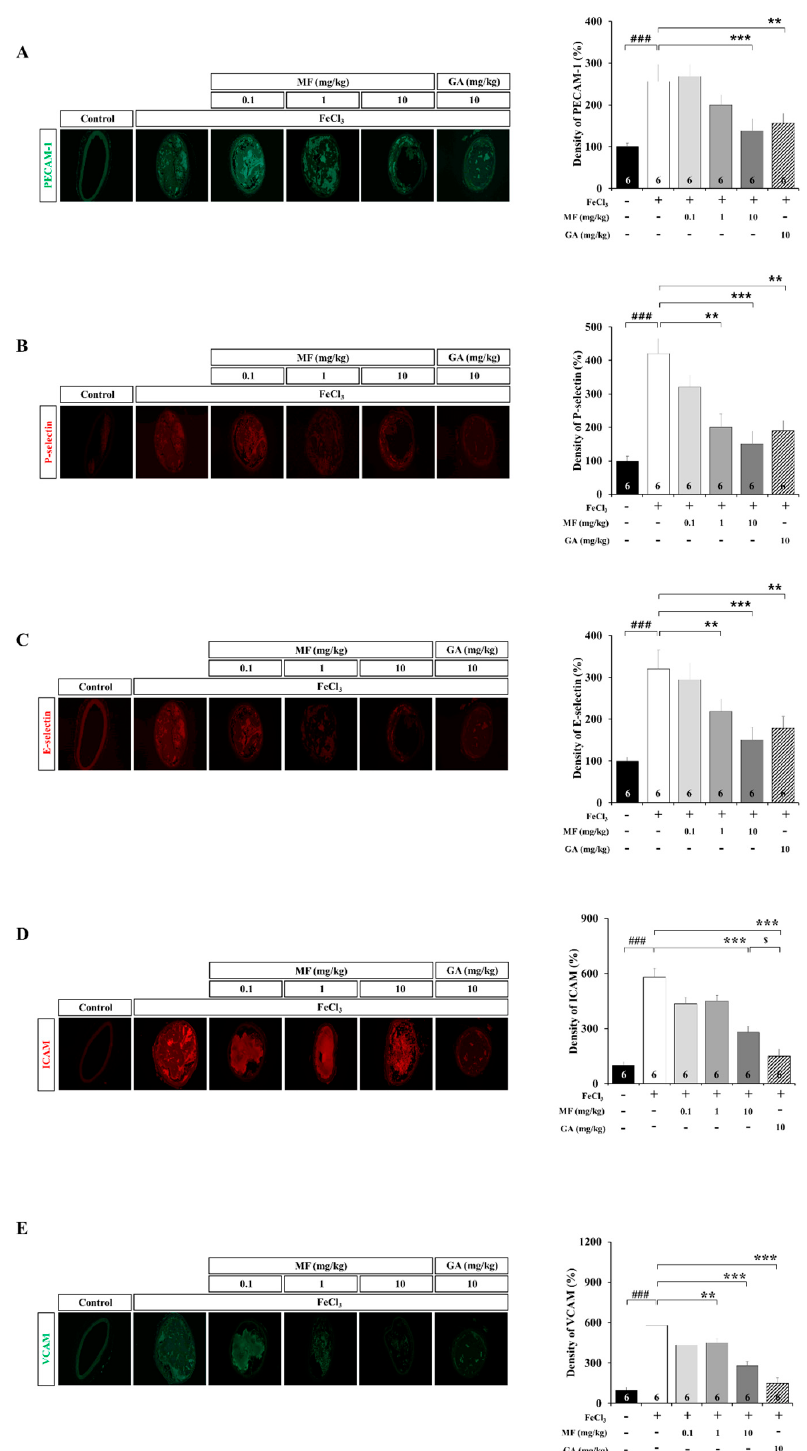
Figure 3. Cell adhesion molecules in an FeCl 3 -induced arterial thrombosis model. Images show immunofluorescence staining for PECAM-1 (green) ( A ), P-selectin (red) ( B ), E-selectin (red) ( C ), ICAM (red) ( D ), and VCAM (green) ( E ). GA was used as a positive Control drug. Data are expressed as mean ± standard deviation. ### p < 0.001, compared with the Control group; ** p < 0.01 and *** p < 0.001, compared with the FeCl 3 group; $ p < 0.05, compared with the FeCl 3 + MF 10 mg / kg group; n = 6 rats per group. MF: mumefural; GA: gingkolide A; PECAM-1: platelet endothelial cell adhesion molecule; ICAM: intercellular adhesion molecule; VCAM: vascular cell adhesion molecule.